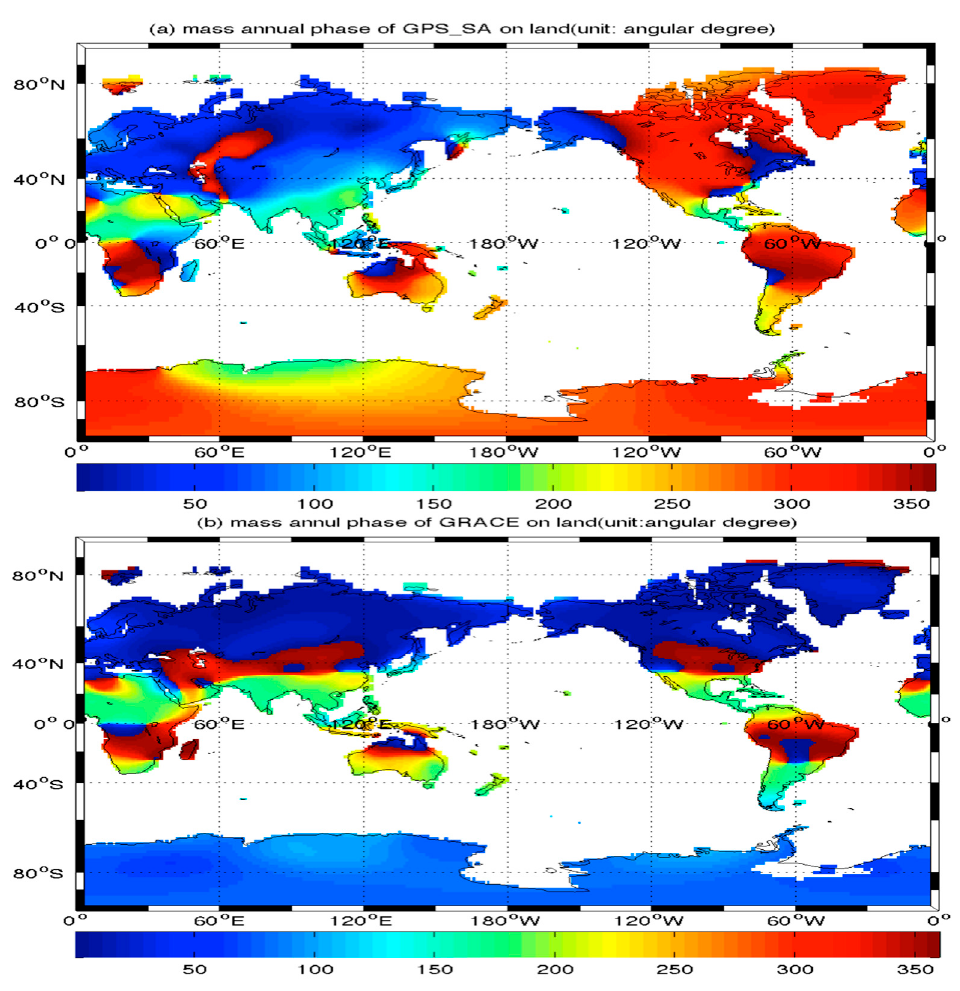
Figure 7. Annual amplitudes of terrestrial water storage derived from GPS+SA and GRACE and GLDAS (unit: mm) using ten years of data from January 2003 to December 2012. For GPS+SA, atmosphere and sea mass variations are removed with GRACE in-situ products. ( a – c ) correspond to results of GPS+SA, GRACE RL05 and GLDAS respectively.